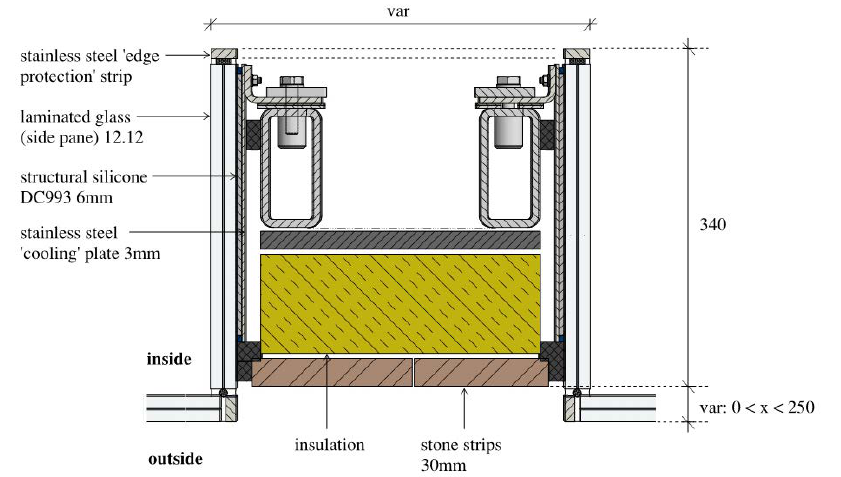
Fig. 11 Horizontal façade detail of two glass boxes that cantilever outwards with brickwork in